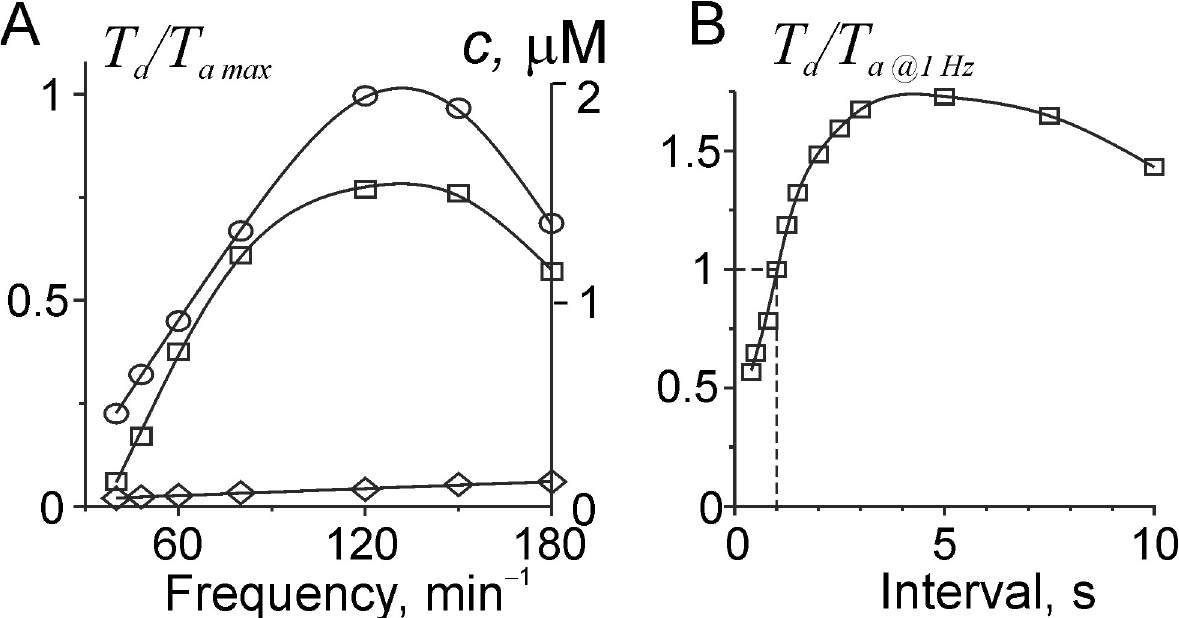
Fig 5. Contraction dependence on the interstimulus interval. A: the dependence of calculated active tension normalized for its steady-state value at saturating Ca 2+ concentration at the same sarcomere length (squares), maximal (circles) and minimal (diamonds) Ca 2+ concentration c in cytosol (right scale) on the stimulation frequency. B: the dependence of peak twitch tension normalized for its value at 1 Hz stimulation on the interval duration after 1 Hz stimulation.